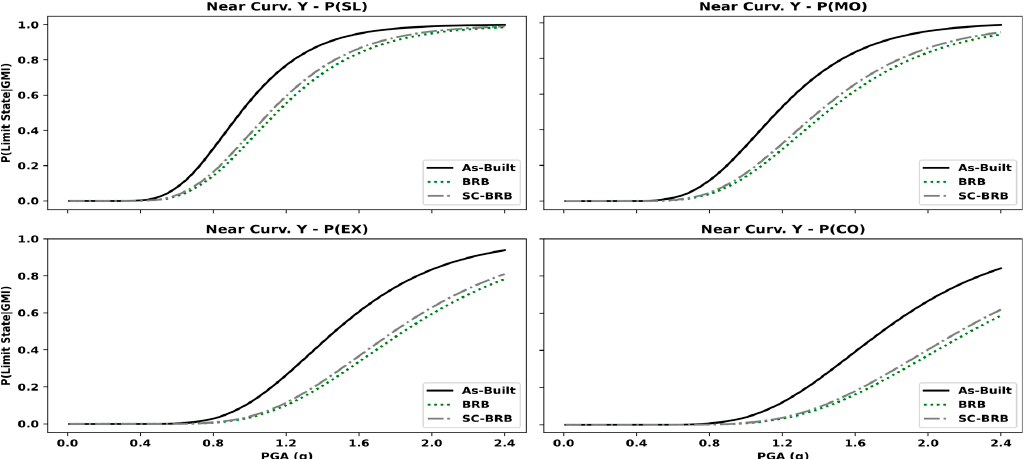
Figure 26. Fragility curves of bridge bent CD demands under near-source records in the transverse direction (as-built vs. retrofitted bridges with different BRB techniques).